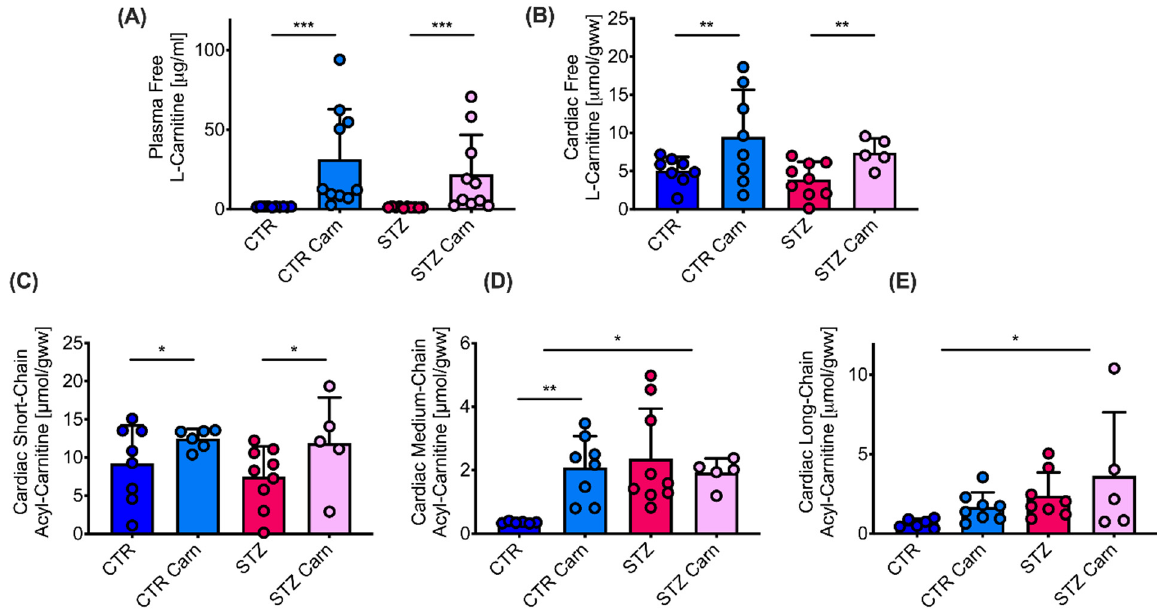
Figure 4. Carnitine modulates cardiac acyl-carnitine species. ( A ) Free L-carnitine in plasma. ( B ) Free L-carnitine in cardiac tissue. ( C ) All short-chain acyl-carnitines summed (C2-C10) in heart tissue. ( D ) All medium-chain acyl-carnitines summed (C12–C15) in heart tissue. ( E ) All long-chain acyl-carnitines summed (>C15) in heart tissue. Data are presented as mean ±